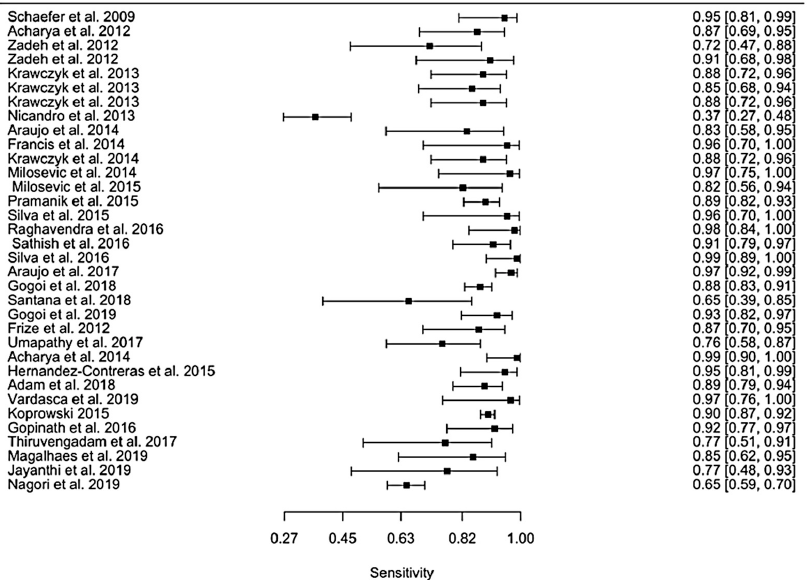
Appl. Sci. 2021 , 11 , x FOR PEER REVIEW Figure 2. Forest plot for sensitivity: all studies combined. Figure 2. Forest plot for sensitivity: all studies combined.